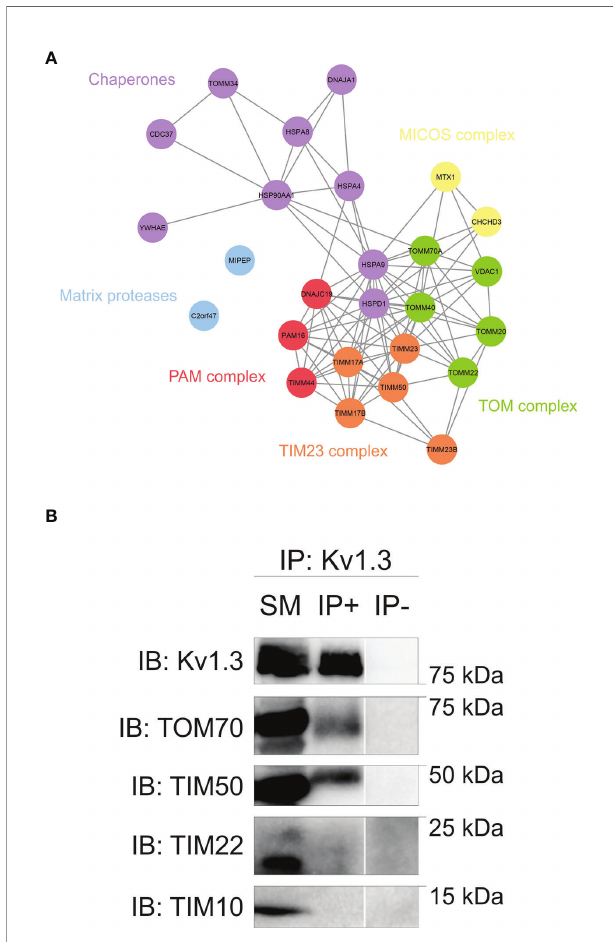
FIGURE 2 | The Kv1.3 interactome reveals an unconventional mitochondrial import pathway for Kv1.3. (A) Network showing protein – protein interactions (PPIs) in the mitochondrial Kv1.3 interactome of HEK 293 cells transfected with Kv1.3YFP. The mitochondrial import subnetwork was obtained after a functional enrichment analysis of the Kv1.3 interactome. A force-directed layout was used for network visualization. Protein names are indicated at the node center. The color code indicates functional relations between proteins (purple, chaperones; blue, matrix proteases; red, PAM complex; orange, TIM23 complex; green, TOM complex; yellow, MICOS complex). TOMM34, CDC37 and YWHAE were manually annotated based on published evidence. (B) HEK 293 cells were transfected with Kv1.3YFP. Total cell lysates (SM, starting materials) were immunoprecipitated against Kv1.3 (IP+). IP-, absence of the Kv1.3 antibody. Samples were immunoblotted (IB) with antibodies against Kv1.3 and different TIM/TOM proteins, as